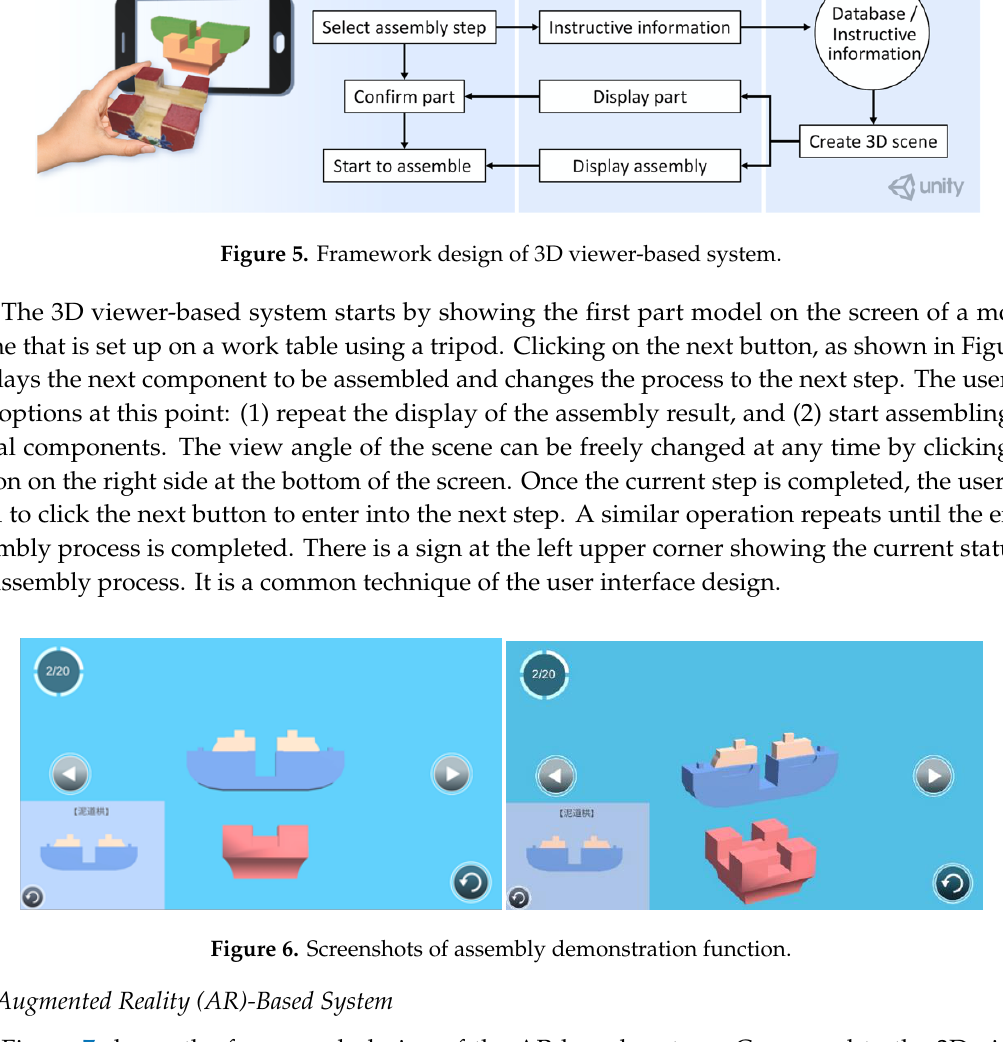
Figure 5. Framework design of 3D viewer-based system.